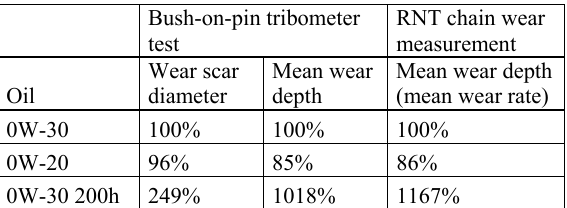
Table 1. Comparison of chain wear results measured on tribometer and engine dynamometer Bush-on-pin tribometer